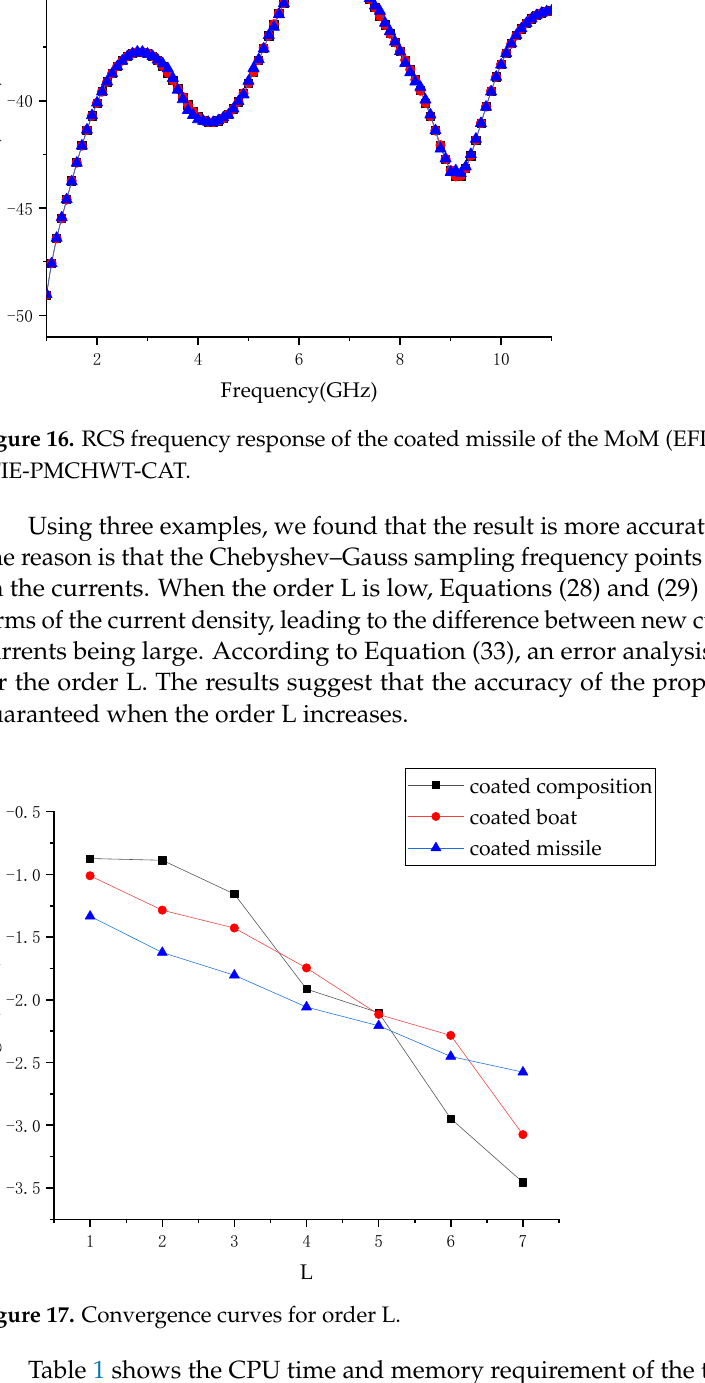
Figure 15. RCS frequency response of the coated missile by using three different orders of EFIE- PMCHWT-CAT and EFIE-PMCHWT.